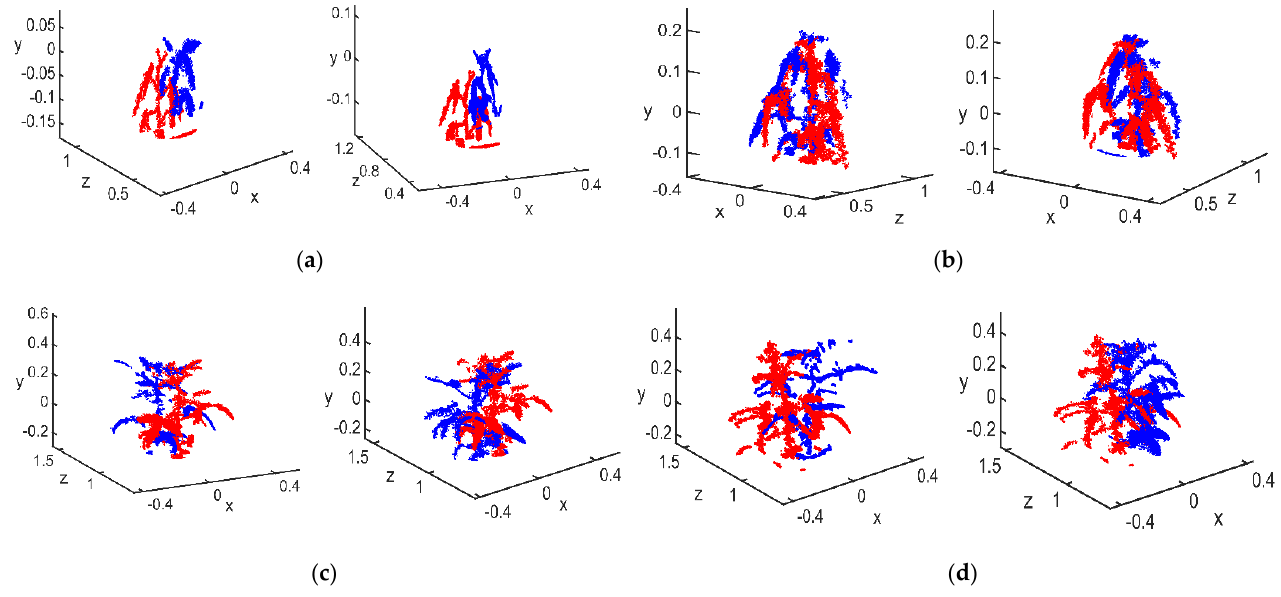
Figure 6. Raw 3D point cloud: ( a ) flowering stage; ( b ) podding stage; ( c ) filling stage; ( d ) mature stage.